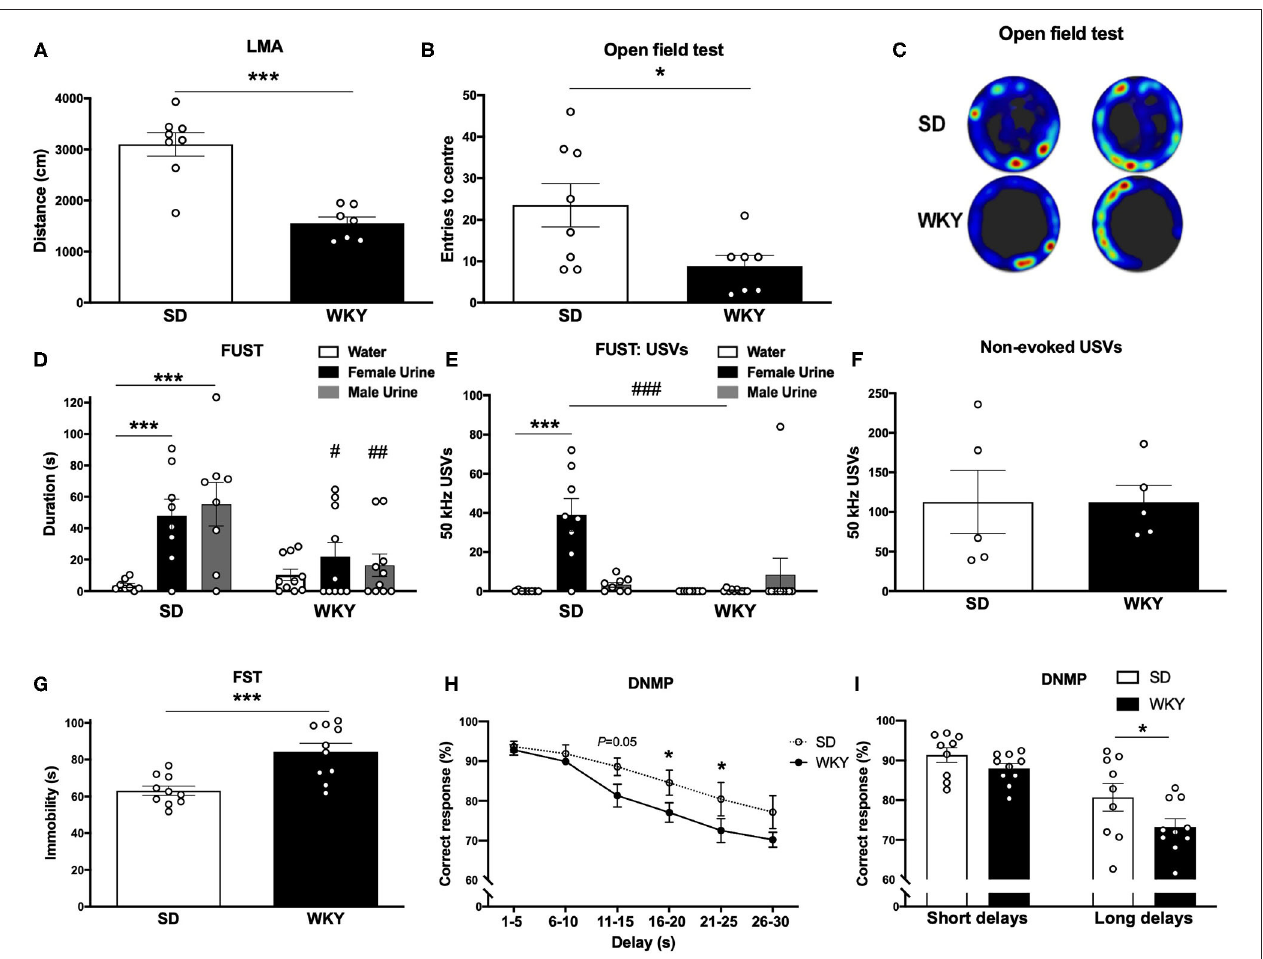
FIGURE 1 | WKY rats showed a depressive-like phenotype in comparison to SD rats. (A) LMA (distance, cm) in OF test. (B) Entries to the centre in OF test. (C) Representative OF heat map from n = 2 SD and WKY rats. (D) Sniffing duration (s) in the FUST. (E) USVs: number of 50kHz calls emitted during FUST. (F) Non-evoked 50kHz calls recorded in the home cage. (G) Immobility in the FST. (H) Correct response in DNMP task stratified by delay period. (I) Correct responses in DNMP task grouped by short and long delay periods. Data are expressed as mean ± SEM, n = 5–10 per group. * p < 0.05, *** p < 0.001, # p < 0.05, ## p <